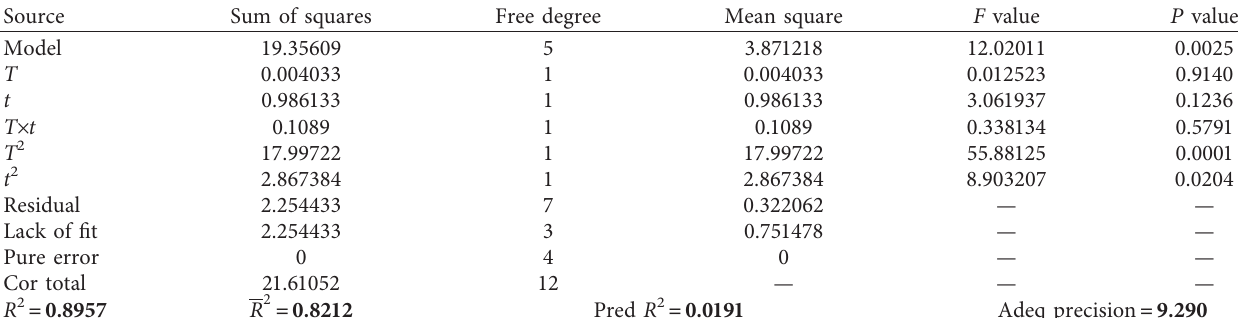
Table 7: Analysis of variance (ANOVA) for the elongation.